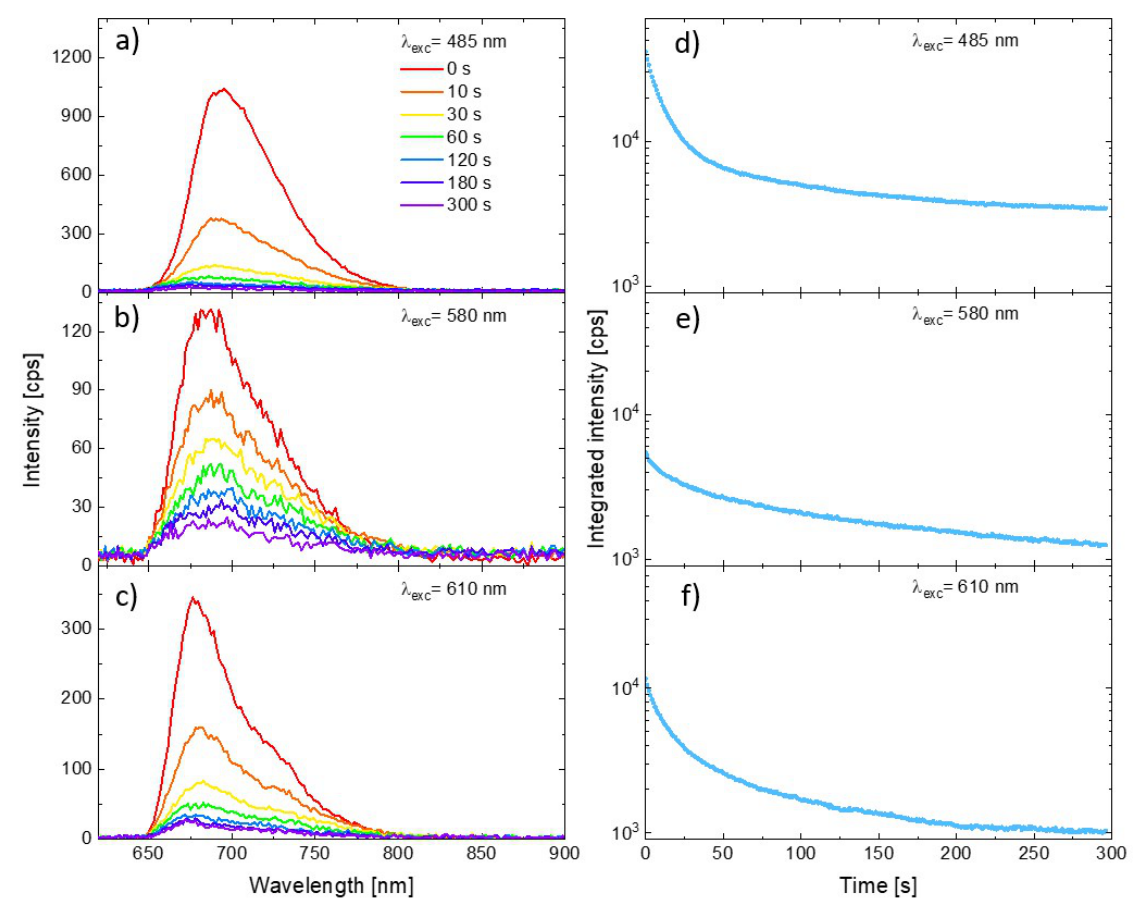
Figure 2. Emission spectra of PSI–LHCI complexes excited at 485 nm ( a ), 570 nm ( b ), and 610 nm ( c ) at the various moments form illumination beginning. Corresponding curves showing temporal changes in the integrated intensity of the spectra (integrated in the range from 650 to 800 nm) are shown in panels ( d – f ).